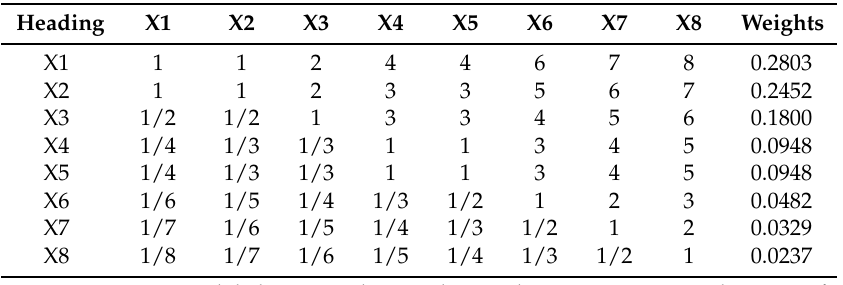
Table 3. The analytic hierarchy process judgment matrix and influencing factor